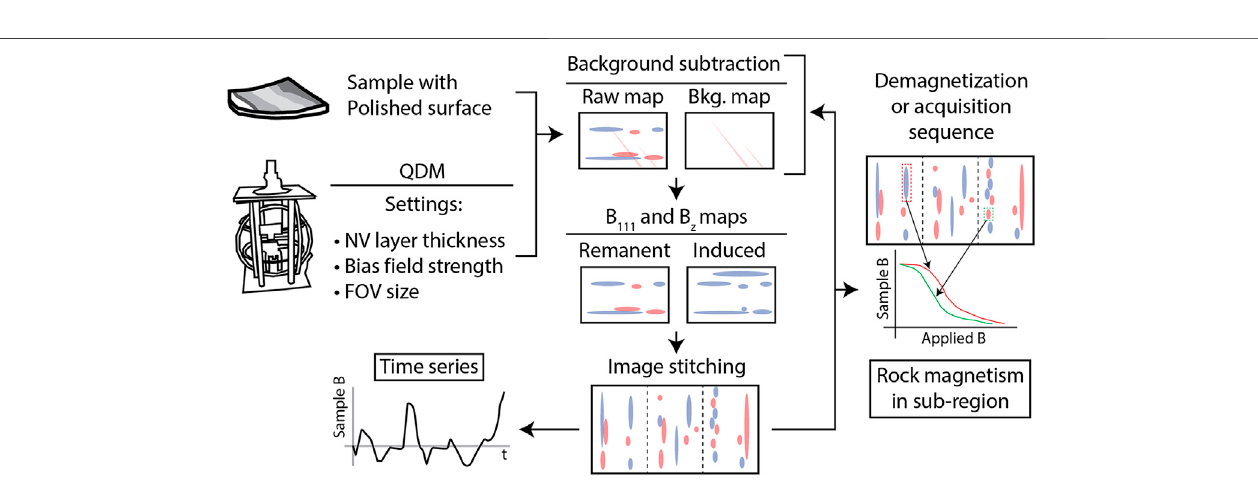
FIGURE3| Flowchartsummaryofexperimental procedure.Afterweobtainarawmapofthemagnetic fi eldinthe < 111 > crystallographicdirection(B 111 ),weapply backgroundsubtractionwherenecessary,converttoB z usingaFourierdomaintransform,andstitchadjacent fi eldsofviewusingtheopticalimageassociatedwitheach magnetic fi eldmap.Atimeseriesofmagnetic fi eldstrength,whichisaproxyformagnetization,canbeobtainedwithanagemodel.Repeatedimagingofthesame fi eld(s) of view combined with a demagnetization or remanence acquisition sequence can be used to construct demagnetization or acquisition curves for small sub- regions.